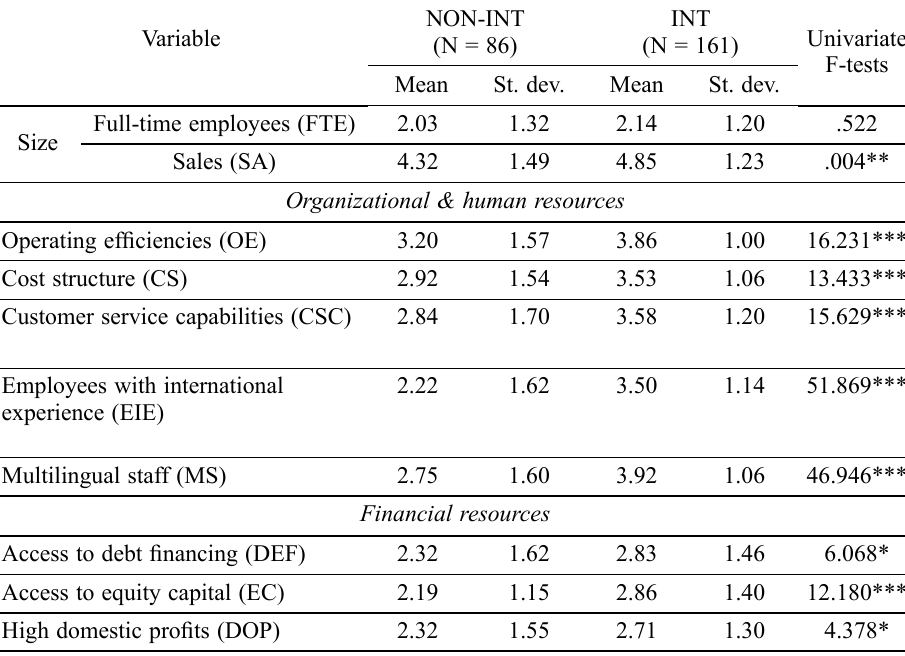
Table 1. Comparison of firm characteristics between